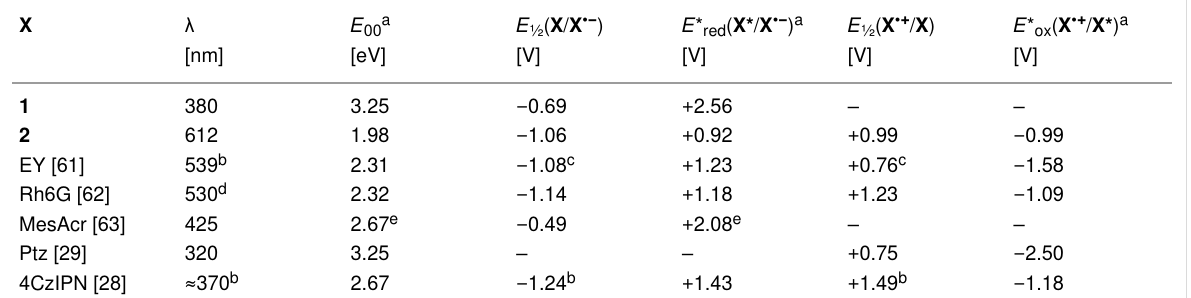
Table 1: Optical and electrochemical properties of NDI 1 and cNDI 2 (in CH 2 Cl 2 ) in comparison to other organic photoredox catalyst X , in particular eosin Y (EY), rhodamine 6G (Rh6G) and 9-mesityl-10-methylacridinium perchlorate (MesAcr) 1,2,3,5-tetrakis(carbazol-9-yl)-4,6-dicyanobenzenes (4CzIPN) and N -phenylphenothiazine